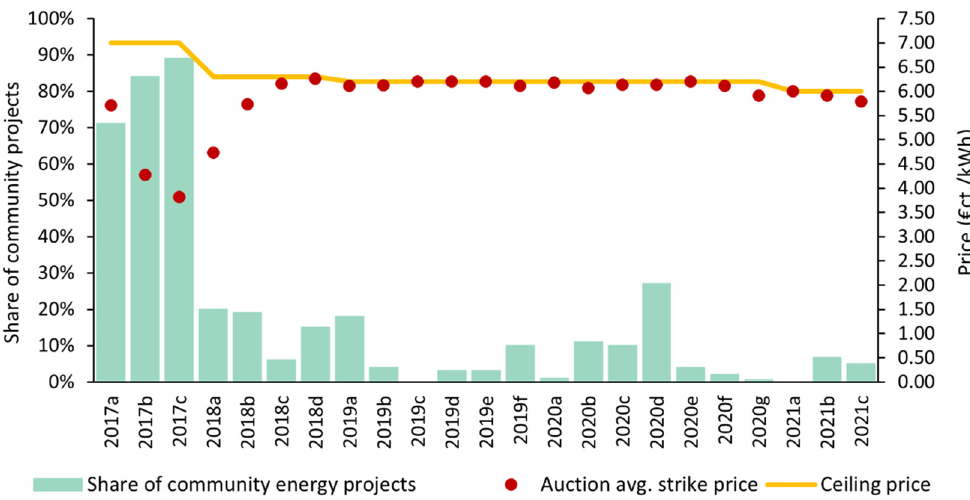
Figure 6. Share of capacity volumes submitted by community energy projects (green bars—%) compared with the evolution of average auction strike prices (red dots—EUR ct/kWh) and maximum allowed bidding (ceiling) prices (yellow line—EUR ct/kWh) for all completed onshore wind energy auction rounds conducted in Germany between 2017–2021. Source: Own elaboration. Data from [165].